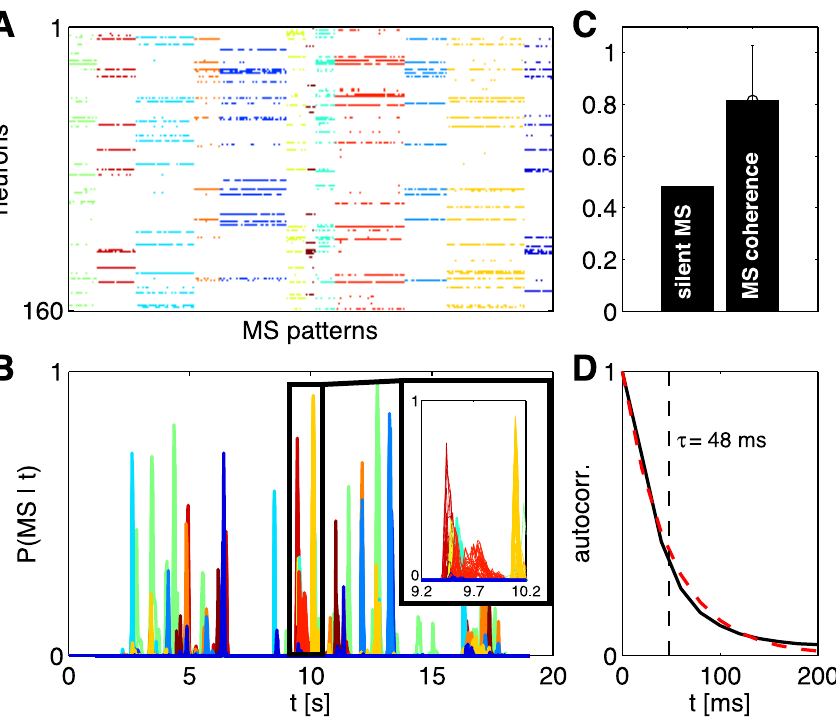
Figure 12. Basin assignments are reproducible across stimulus repeats and across subnetworks. ( A ) Most frequently occurring MS patterns collected from 30 subnetworks of size N =120 out of a total population of 160 neurons; patterns have been clustered into 12 clusters (colors). ( B ) The probability (across stimulus repeats) that the population is in a particular basin of attraction at any given time. Each line corresponds to one pattern from (A); patterns belonging to the same cluster are depicted in the same color. Inset shows the detailed structure of several transitions out of the all-silent state; overlapping lines of the same color show that the same transition is identified robustly across different subnetwork choices of 120 neurons out of 160. ( C ) On about half of the time bins, the population is in the all-silent basin; on the remaining time bins, the coherence (the probability of being in the dominant basin divided by the probability of being in every possible non-silent basin) is high. ( D ) The average autocorrelation function of traces in (B), showing the typical time the population stays within a basin (dashed red line is best exponential fit with t =48 ms, or about 2.5 time bins).